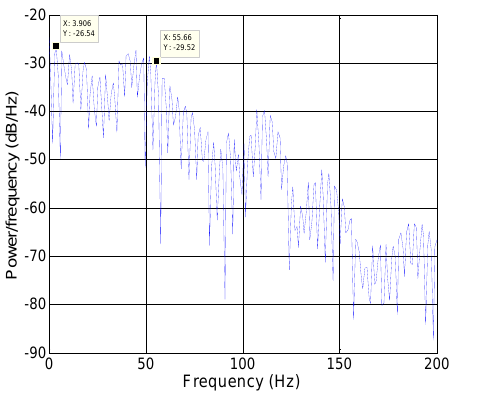
Fig. 21. Periodogram: Llinear case. Fig. 22. Periodogram: Nnonlinear